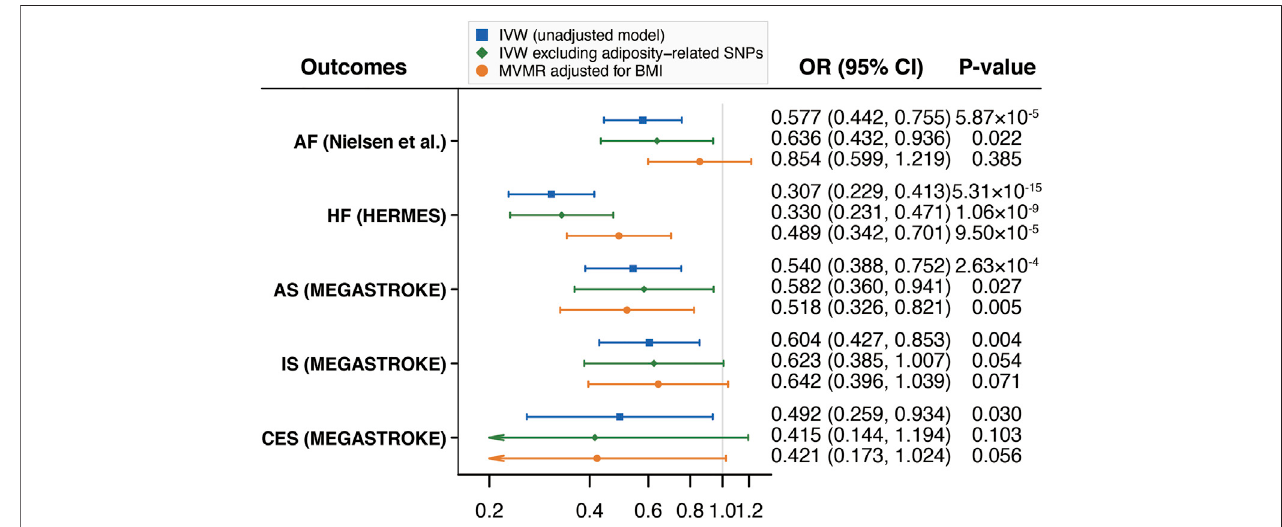
FIGURE2| Mendelianrandomizationanalysesoftheassociationsofself-reportedwalkingpacewithCVDexcludingadiposity-relatedSNPsandadjustingforBMI. Abbreviations: CVD, cardiovascular diseases; SNPs, single nucleotide polymorphisms; BMI, body mass index; IVW, inverse variance weighted; MVMR, multivariable Mendelianrandomization;OR,oddsratio;CI,con fi denceinterval;HERMES,HeartFailureMolecularEpidemiologyforTherapeuticTargets;AF,atrial fi brillation;HF,heart failure; AS, any stroke; IS, ischemic stroke; CES, cardioembolic